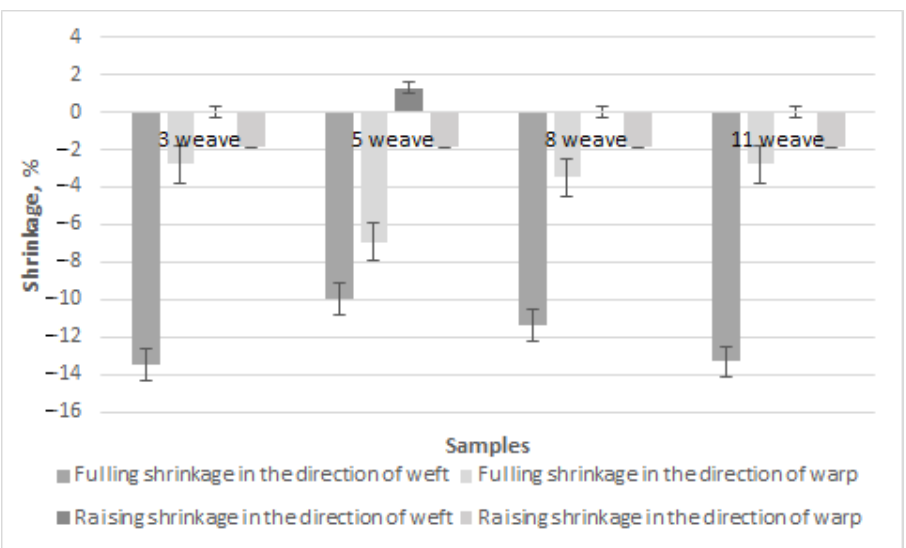
Figure 7. Fulling and raising shrinkage in the directions of the warp and weft of Series 2 100% woolen fabrics.